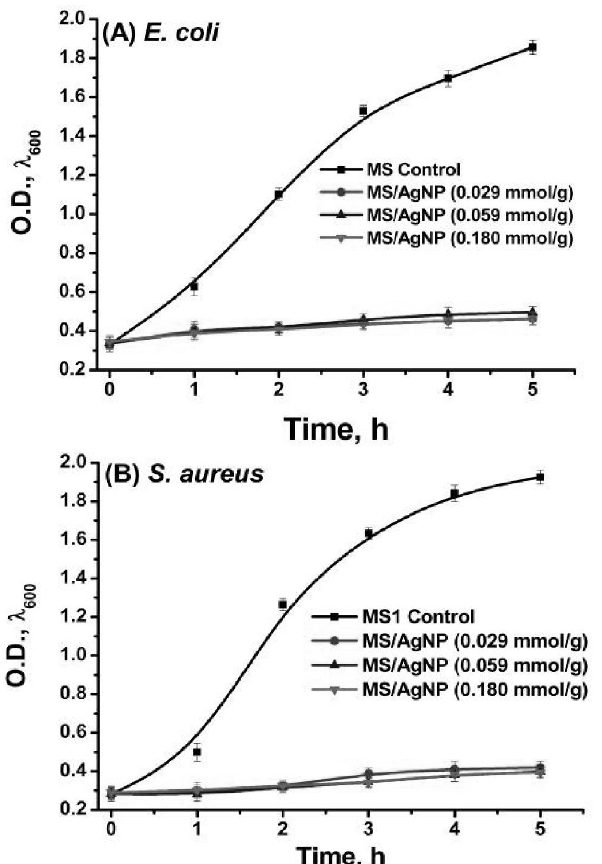
Figure 6. Bacterial growth curves in Lysogeny broth (LB) growth media, for ( A ) E. coli ; and ( B ) S. aureus using MS/AgNP prepared at increasing Ag loading. Bacterial growth was monitored measuring the O.D. 600